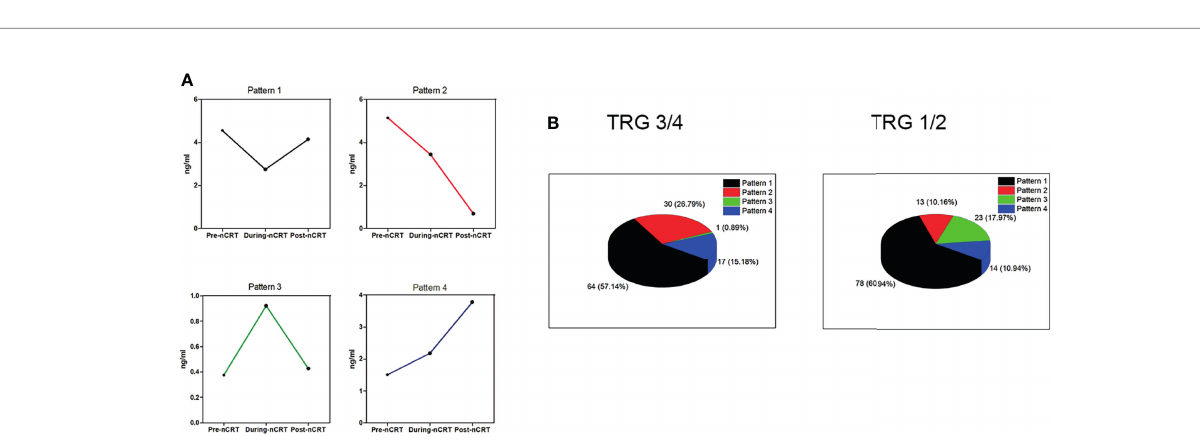
FIGURE 3 | The change patterns of sPD-L1, sCD80, sCD86, sCD28, sGITR, sGITRL, sCD27, and sICOS. (A) Each soluble immune checkpoint molecule shows four different patterns of change based on three time-points. (B) The percentage of the four patterns in the TRG3/4 group (left) and the TRG1/2 group (right).